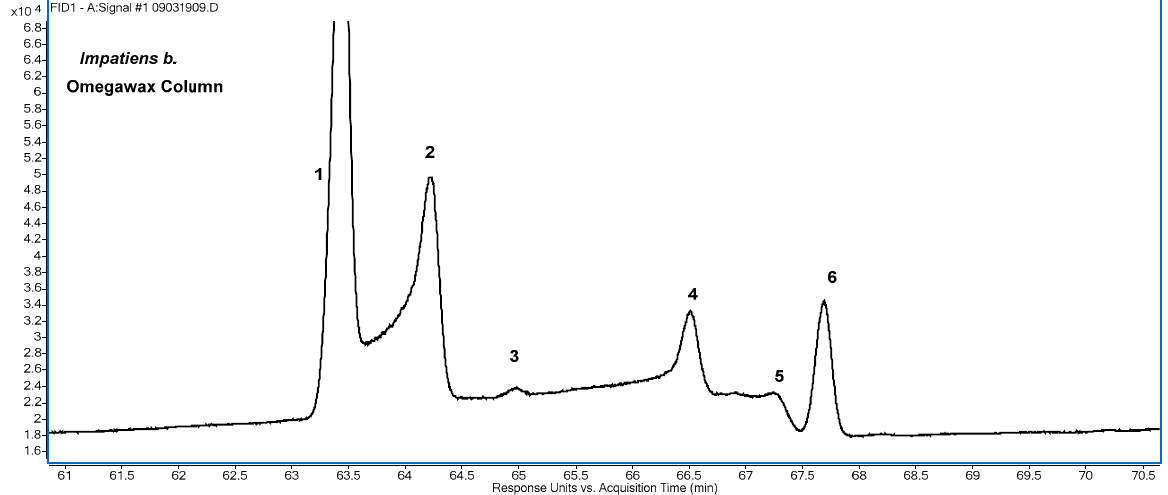
Figure 7. CSDA region of FID chromatogram of Impatiens b. obtained using the Omegawax column. Peak 1 is assigned as the FAME of α -parinaric acid ( cttc ); peak 2 is assigned as the FAME of the cttt isomer; peak 3 is a possible CSDA isomer of unknown geometric configuration; peak 4 is assigned as the FAME of the tttc isomer; and peak 5 is assigned as the FAME of β -parinaric acid ( tttt ). Peak 6 is squalene.